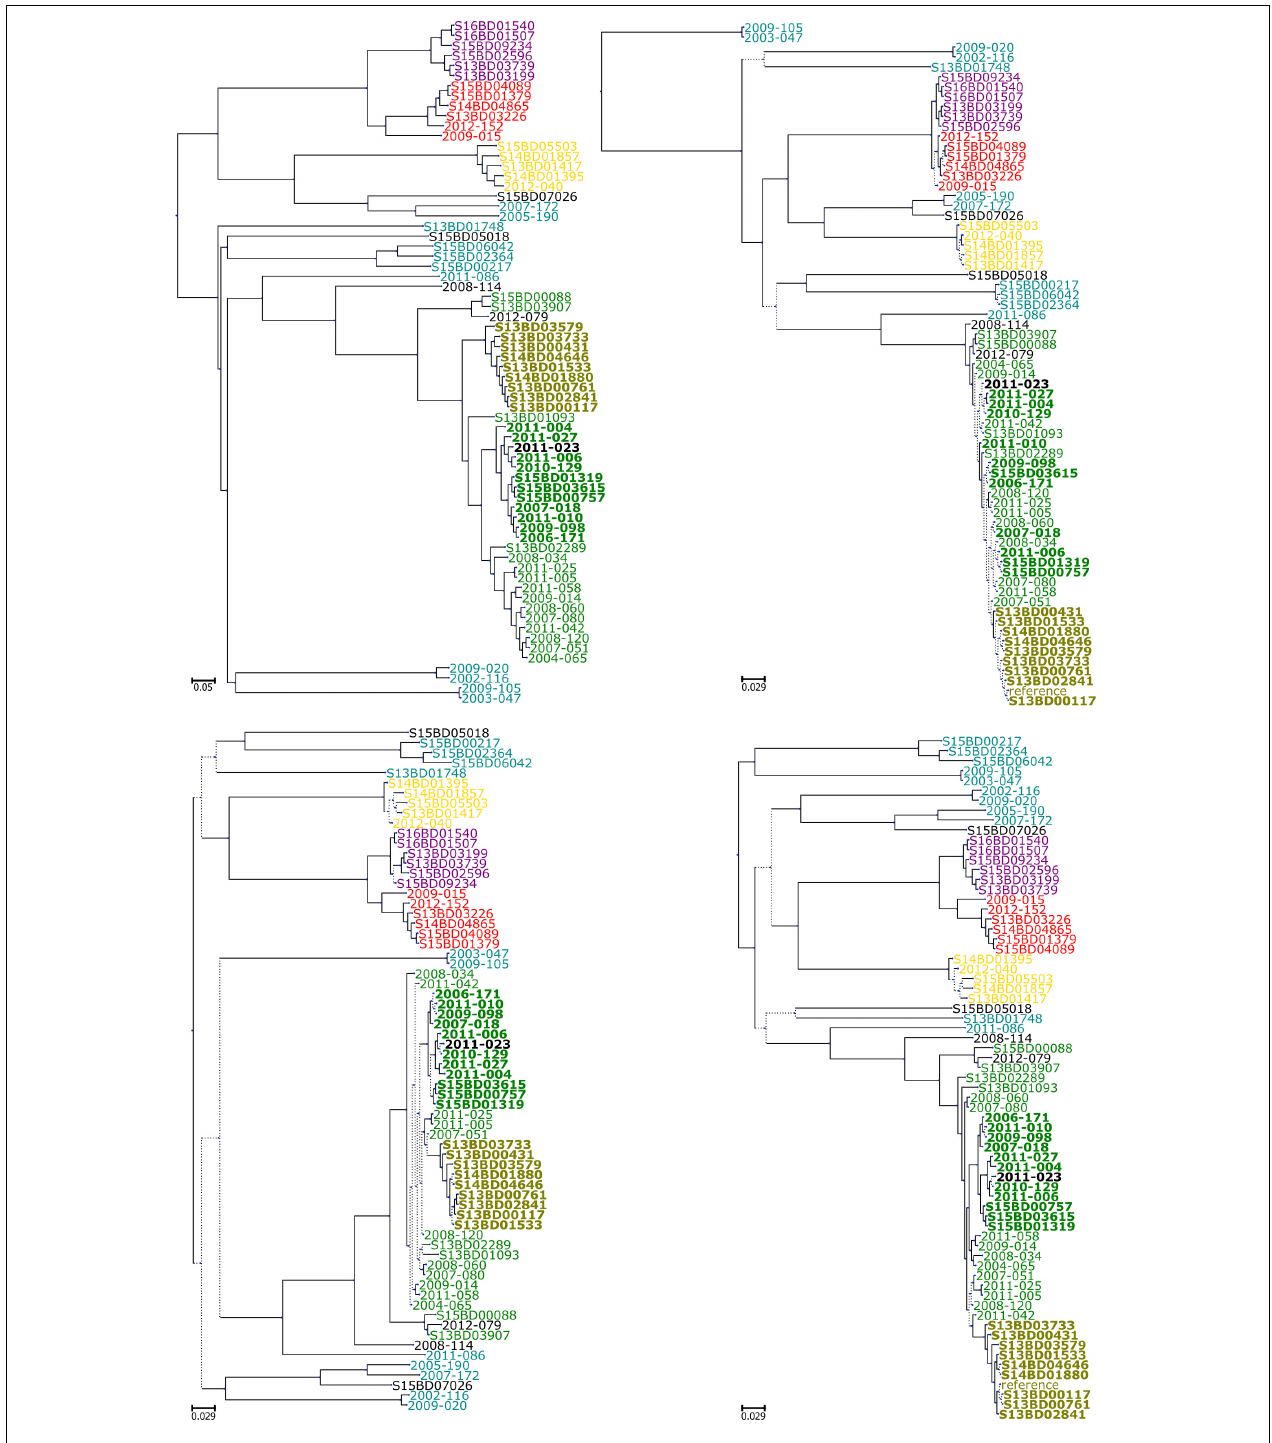
FIGURE 3 | Initial comparison of the subtyping workflows. Upper left panel: phylogenetic tree generated with cgMLST. Upper right panel: phylogenetic tree generated with PanseqGu. Lower left panel: phylogenetic tree generated with kSNPRead. Lower right panel: phylogenetic tree generated with SMALTPpl. All phylogenetic trees were obtained using the large dataset 1 (LD1). For the SMALTPpl (lower right panel) and ParsnpGu (upper right panel) workflows, PacBio was used as reference genome. Branches with support values lower than 70% are displayed as dotted lines. Color codes: red: serogroup W, yellow: serogroup Y, purple: serogroup C, green: serogroup B isolates belonging to cc-269 clonal complex except one sub-branch, B:NT:P1.5,2 ∗ , which is colored olive , cyan: serogroup B isolates belonging to other clonal complexes than cc-269, black: serogroup B isolates with undetermined clonal complex. Two clades of cc-269 isolates discussed in more detail in the main text, B:NT:P1.14 ST2693 and B:NT:P1.5,2 ∗ are indicated in bold.